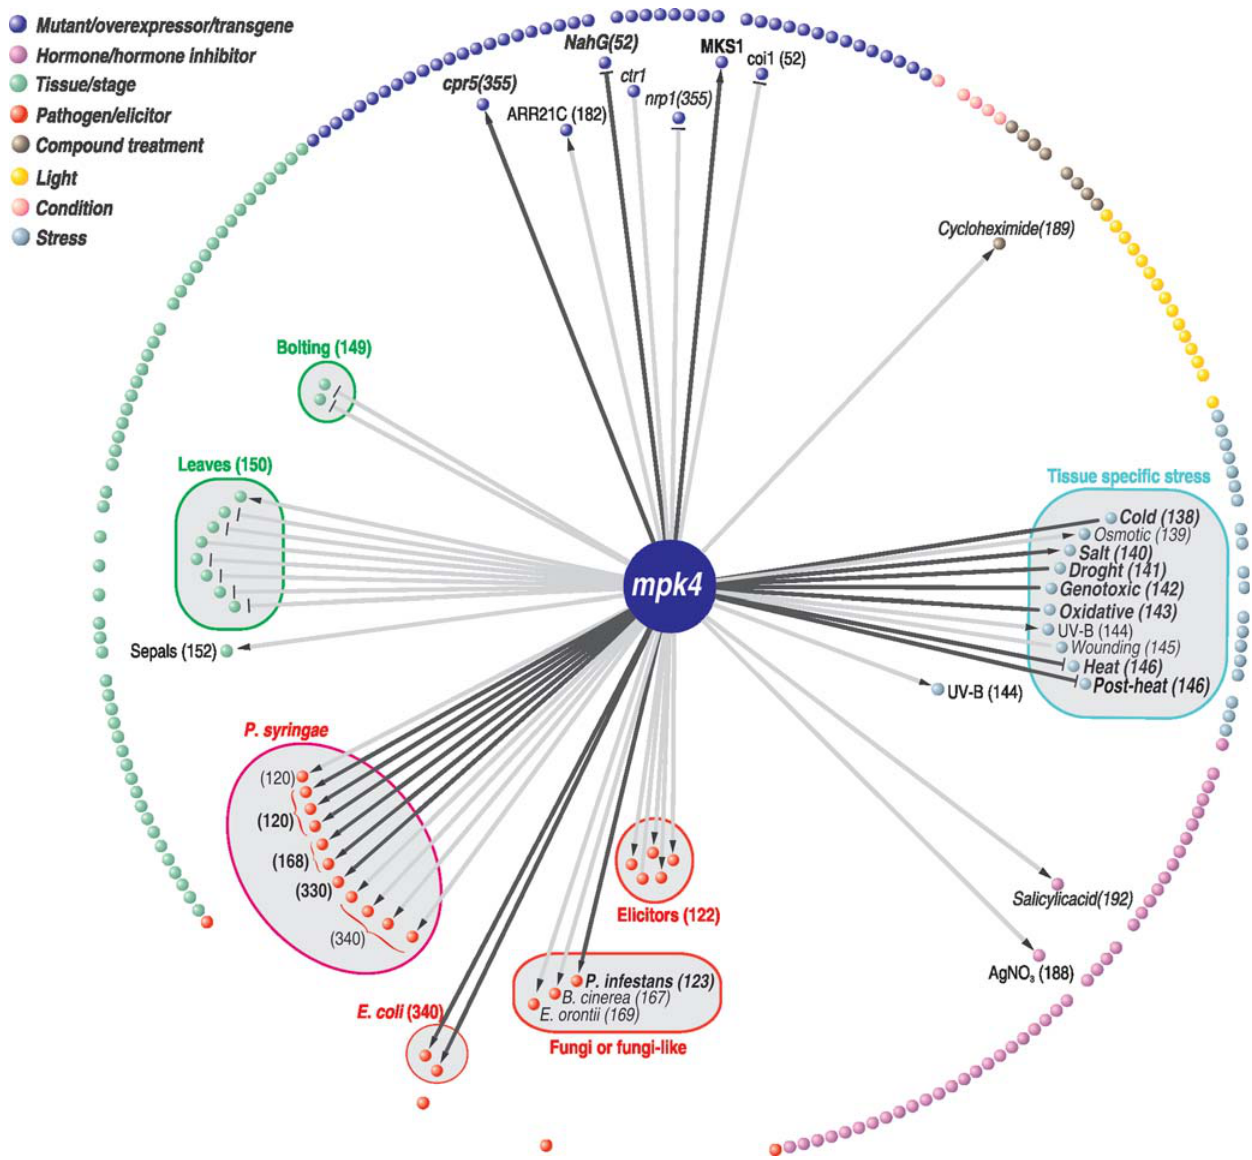
Figure 2. FARO map of the Arabidopsis mpk4mutant. The 241 experimental factors (spheres/nodes) in the compendium of responses are divided into 8 categories indicated by different colors. Only edges (lines connecting factors) and names for experimental factors with strong associations to the mpk4 mutant are shown. Thicker edges and bold factor fonts indicate increasing association strength. Edge arrows or hammerheads, respectively, indicate highly significant congruent or dissimilar (opposite) response direction of the overlapping genes. Significant factors are positioned inside the circle of non-significant factors solely for typographical reasons. NASCArray accession numbers are in parentheses.